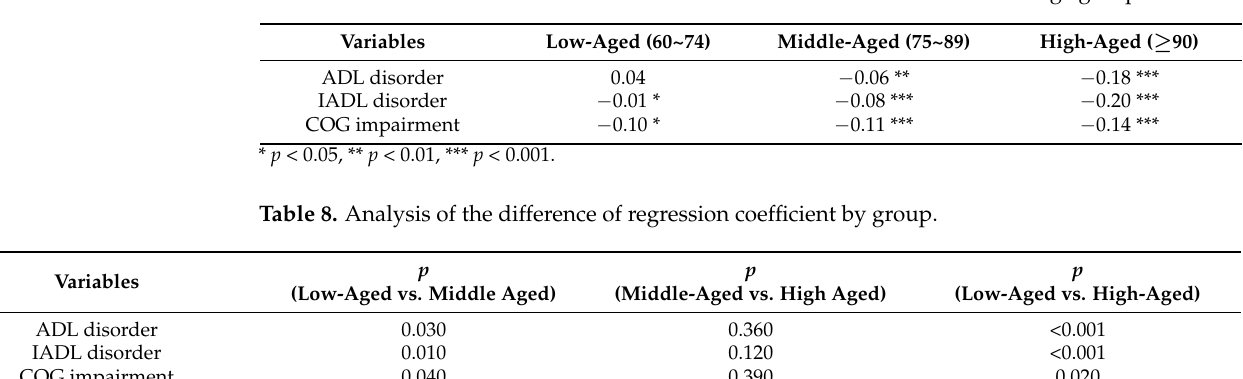
Table 7. The effect of leisure activities on the health of older adults in different age groups.